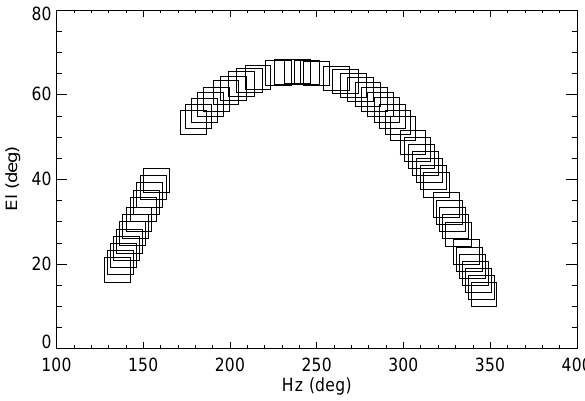
Fig. 3. Successive sun-tracking windows for Position 1, collected on 14 July 2010.